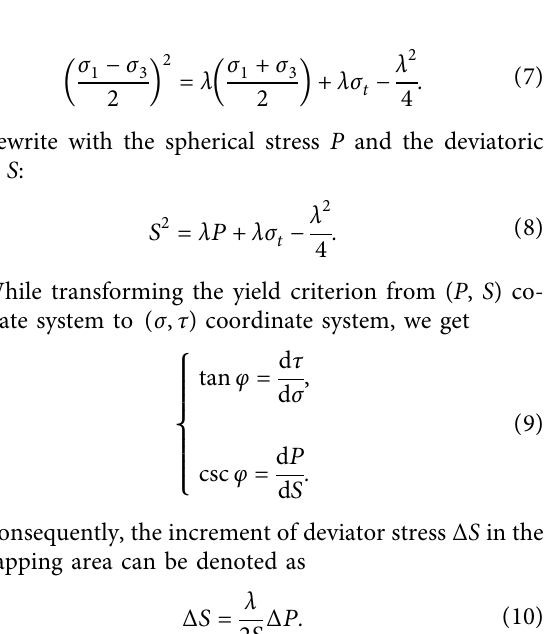
Figure 2: Parabolic Mohr strength criterion in different coordinate systems: (a) σ ∼ τ ; (b) σ